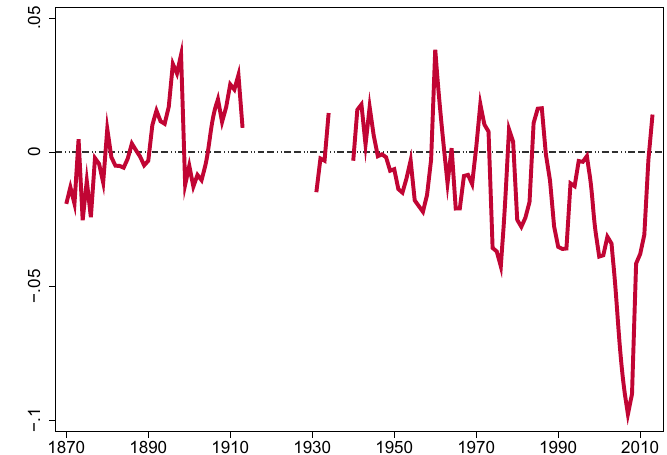
Fig. 1 Current account balance as a share of GDP in Spain 1870–2015. Source: Jordá, Schularick, and Taylor (2017) “Macrofinancial History and the New Business Cycle Facts”. in NBER Macroeconomics Annual 2016, volume 31, edited by Martin Eichenbaum and Jonathan A. Parker. Chicago: University of Chicago Press